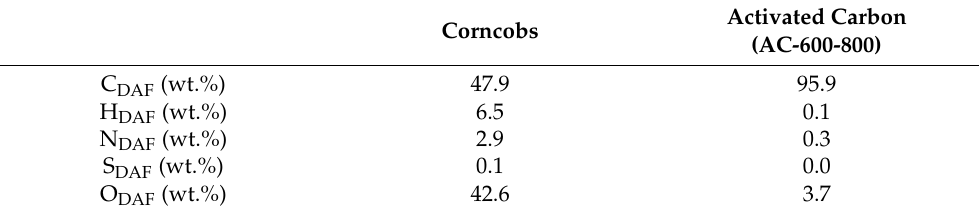
Table 1. Elemental composition of the corncobs and the activated carbon used as precursor for the production of the electrode material. The elementary composition is given on a dry and ash free (DAF) basis. The ash content was calculated by difference.